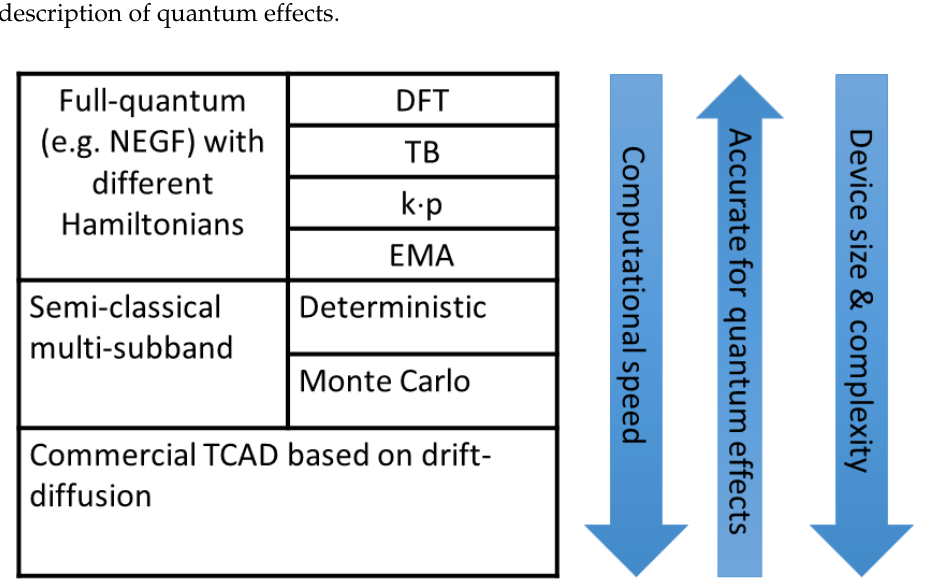
Figure 1. Model hierarchy for III–V channel nanoscale MOSFETs.